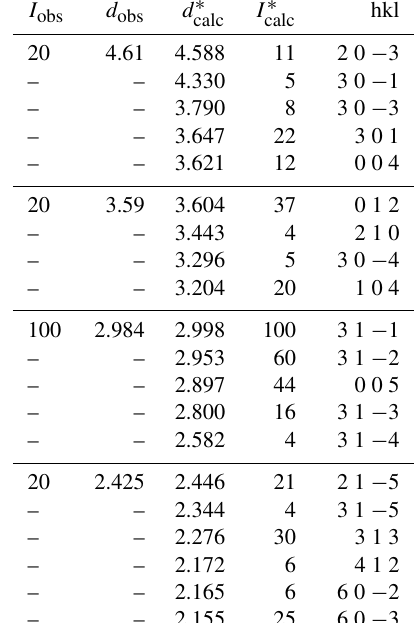
Table 2. X-ray powder diffraction pattern of luxembourgite ( d in